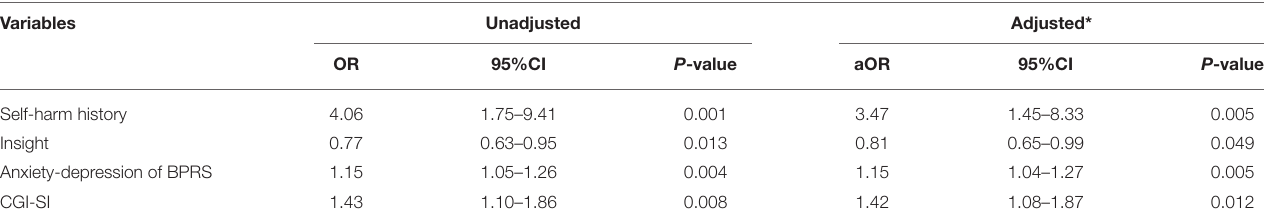
TABLE 3 | Factors associated with suicide risk among forensic psychiatric inpatients (Binary logistic regression